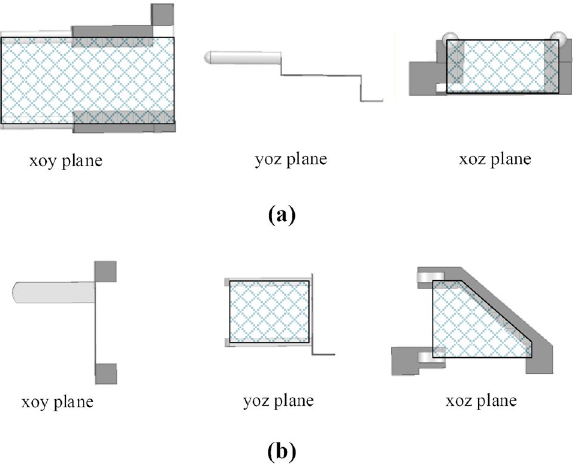
Figure 26. Three views of two structures in three planes: ( a ) original structure; ( b ) proposed